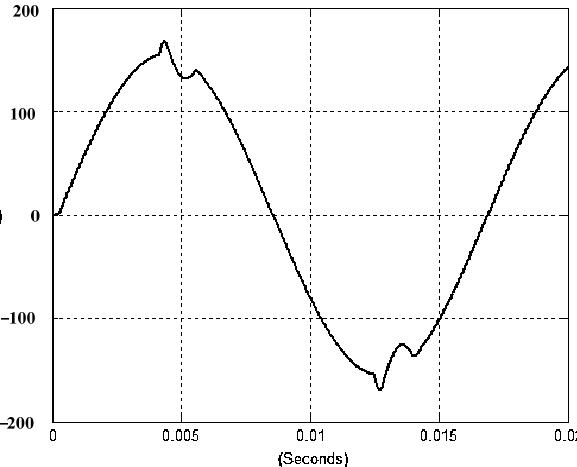
Figure 7. Simulated AC output voltage for the traditional SMRL under a sudden removal of load.